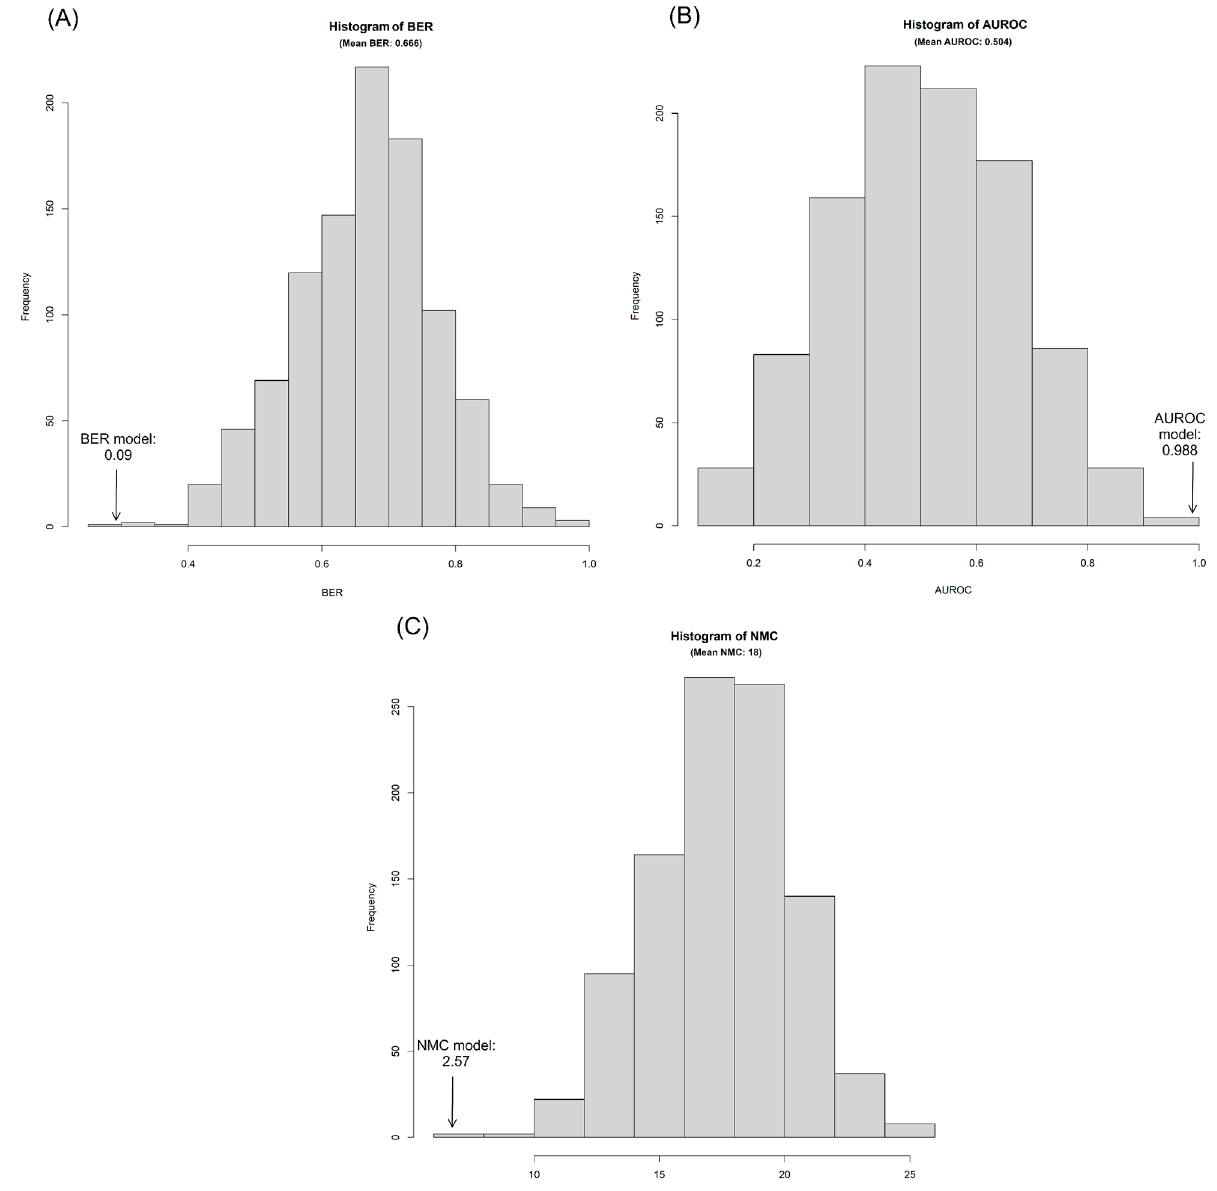
Figure 4. Results from the permutation test ( n = 1000) performed on the multilevel partial least squares discriminant analysis (ML-PLS-DA). Histogram obtained from the permutation test for ( A ) the balanced error rate (BER), ( B ) area under the receiver operating characteristic curve (AUROC), and ( C ) the average number of misclassified (NMC). The real average performance of the model for the three statistics obtained from the double cross-validation is shown in each plot.